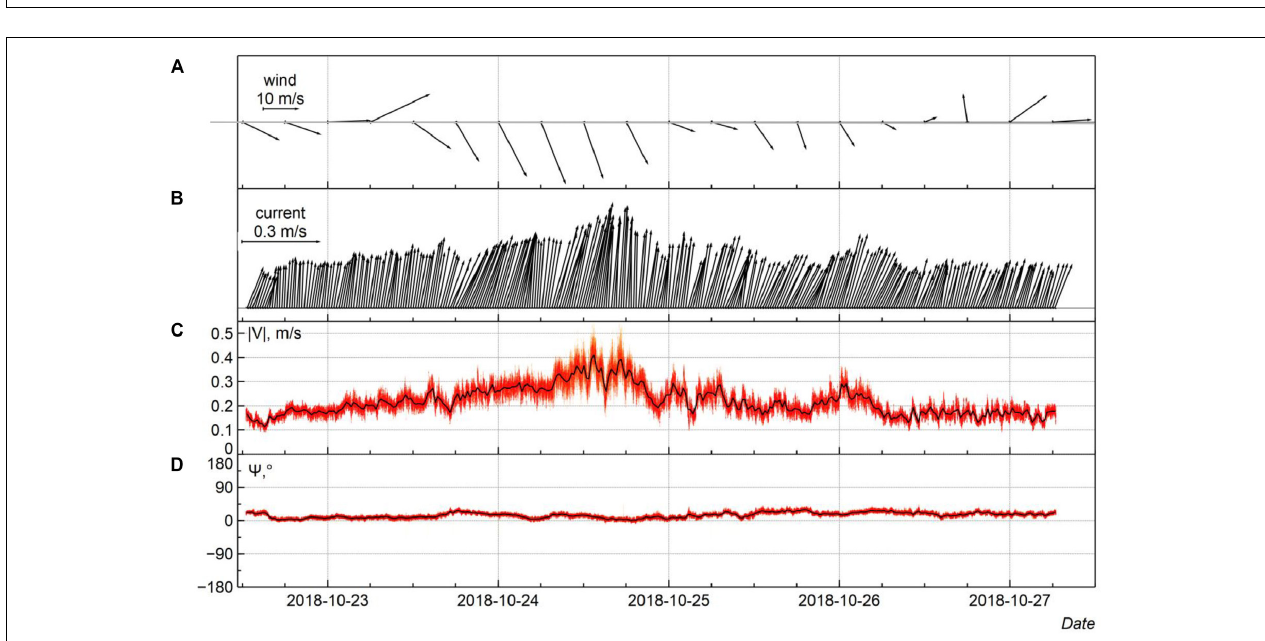
FIGURE 12 | The bottom current measured by TCM was installed on the eastern slope of the Hoburg Channel (see Figure 5 ) for the period 22–27.10.2018. (A) wind vectors with a 6 h interval for the point (19 ◦ E, 56 ◦ N) from the ECMWF database (www.ecmwf.int), (B) current velocity vectors, (C) current velocity magnitude |V| (red line is the instant current, black line is the 20 min running average value), (D) current direction (cid:57) relative to North and positive clockwise.